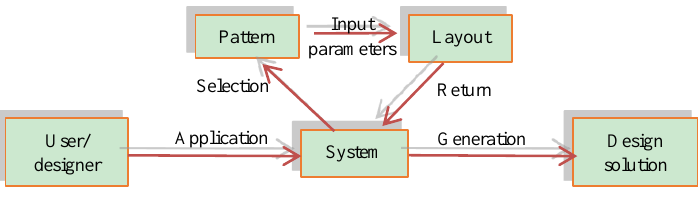
Figure 11. System implementation process.